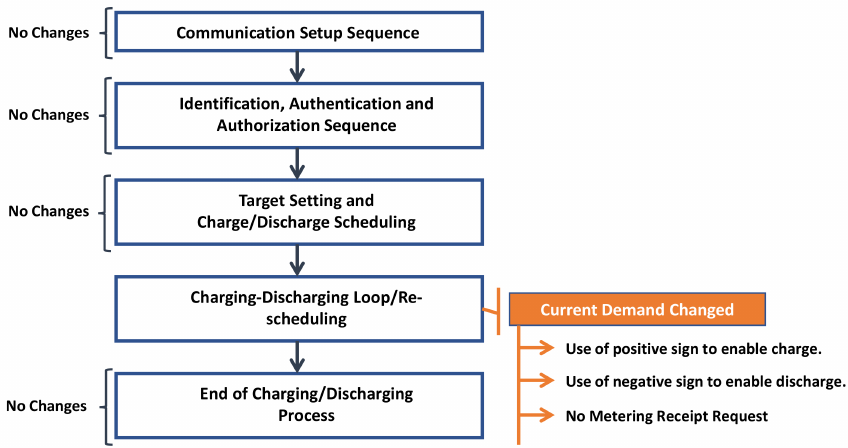
Figure 8. The software modification for V2G